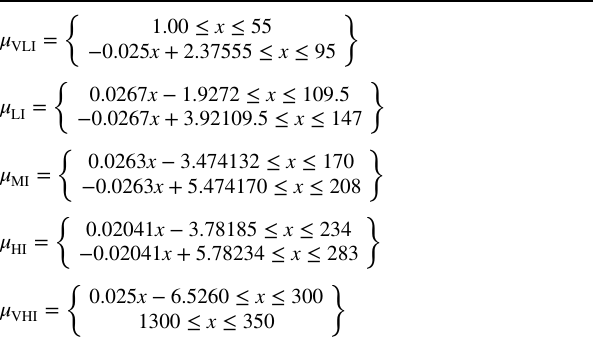
Table 3 Membership function and extent–universe outflow